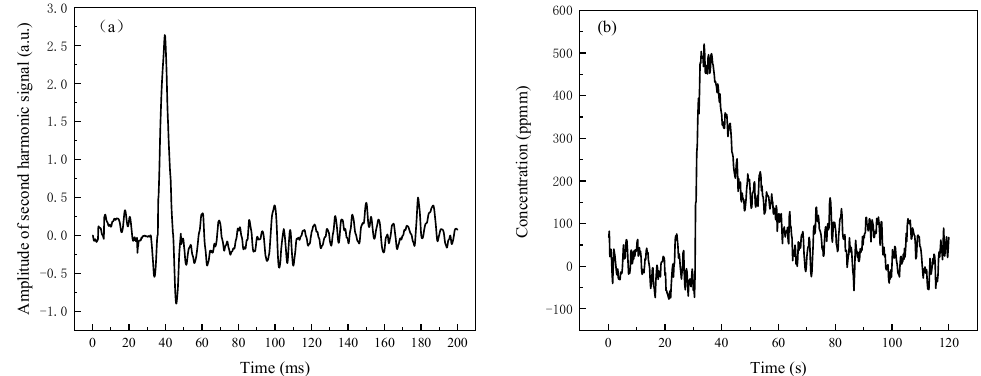
Figure 6. Remote detection result of CO based on TDLAS in the open optical path: ( a ) waveforms of the second harmonic signal; and ( b ) fluctuations of the concentration.